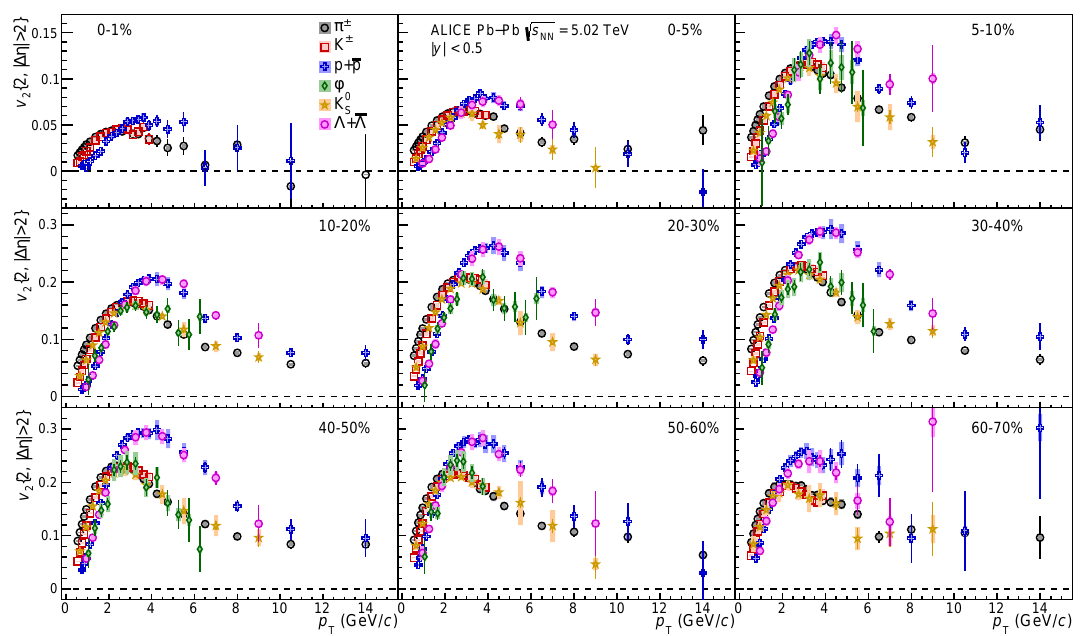
Figure 7. The p T -differential v 2 for different particle species, measured in Pb–Pb collisions at √ s NN = 5.02 TeV for different centrality classes. Figure taken from [19].